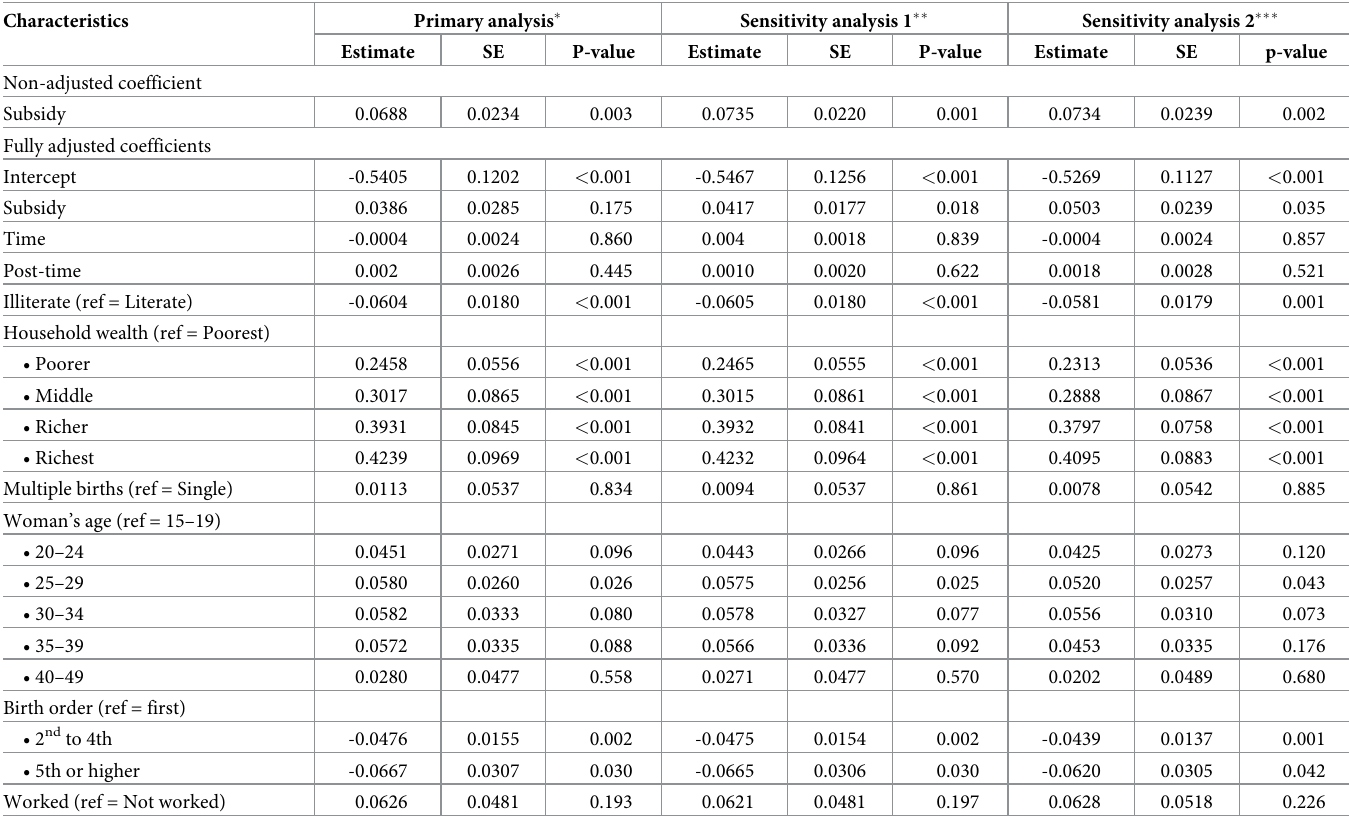
Table 3. Estimates for different Poisson regression models for the effects of the national subsidy on birth attendance in a health facility in urban Burkina Faso (Demographic and Health Survey 2010).